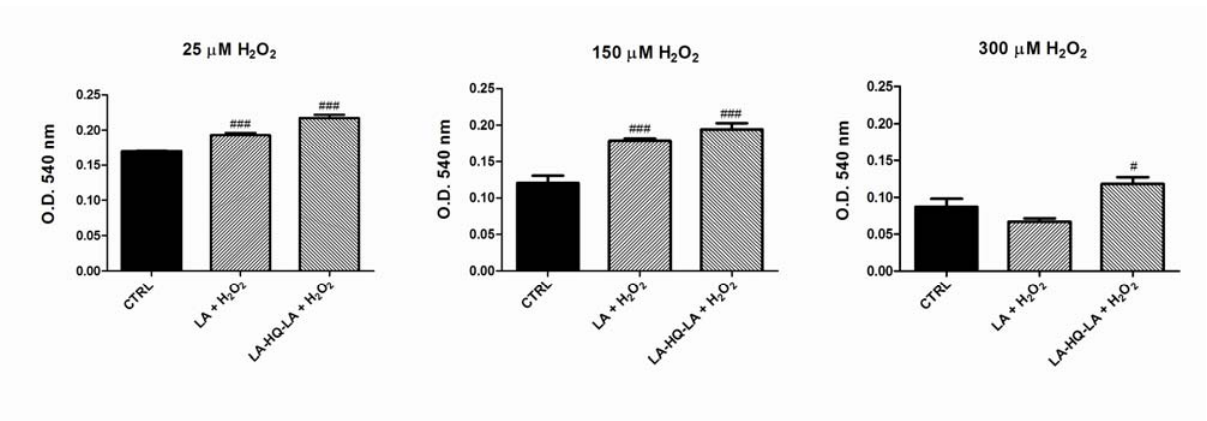
Figure 3. Neuroprotective effects of LA and LA-HQ-LA in undifferentiated and H O -lesioned SH-SY5Y human neuroblastoma cells. 2 2